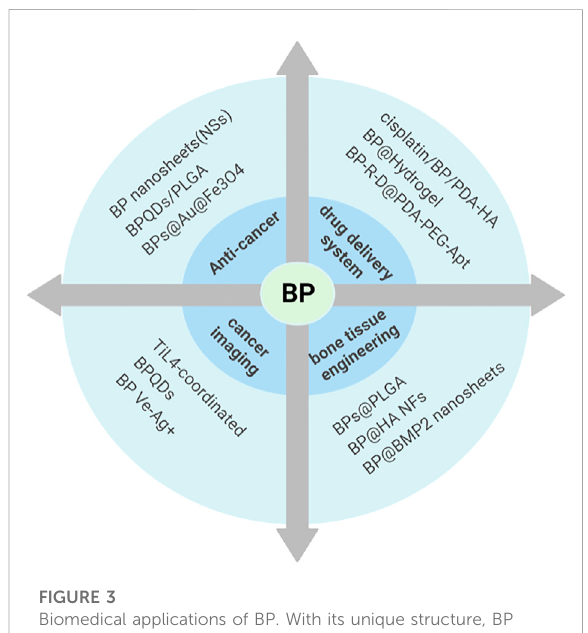
FIGURE 3 Biomedical applications of BP. With its unique structure, BP has been more and more favored in anti-tumor, drug-targeted delivery,photoacousticimaging,andbonetissueengineeringafter various modi fi